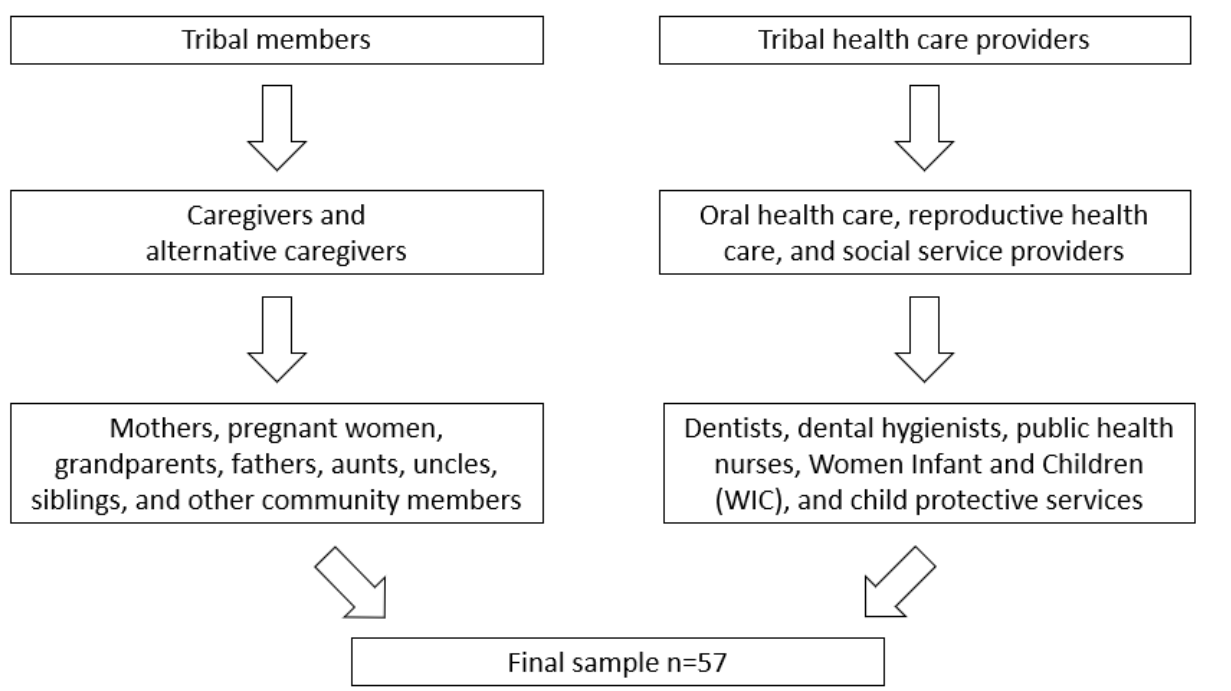
Figure 1. Flow chart of study participants .